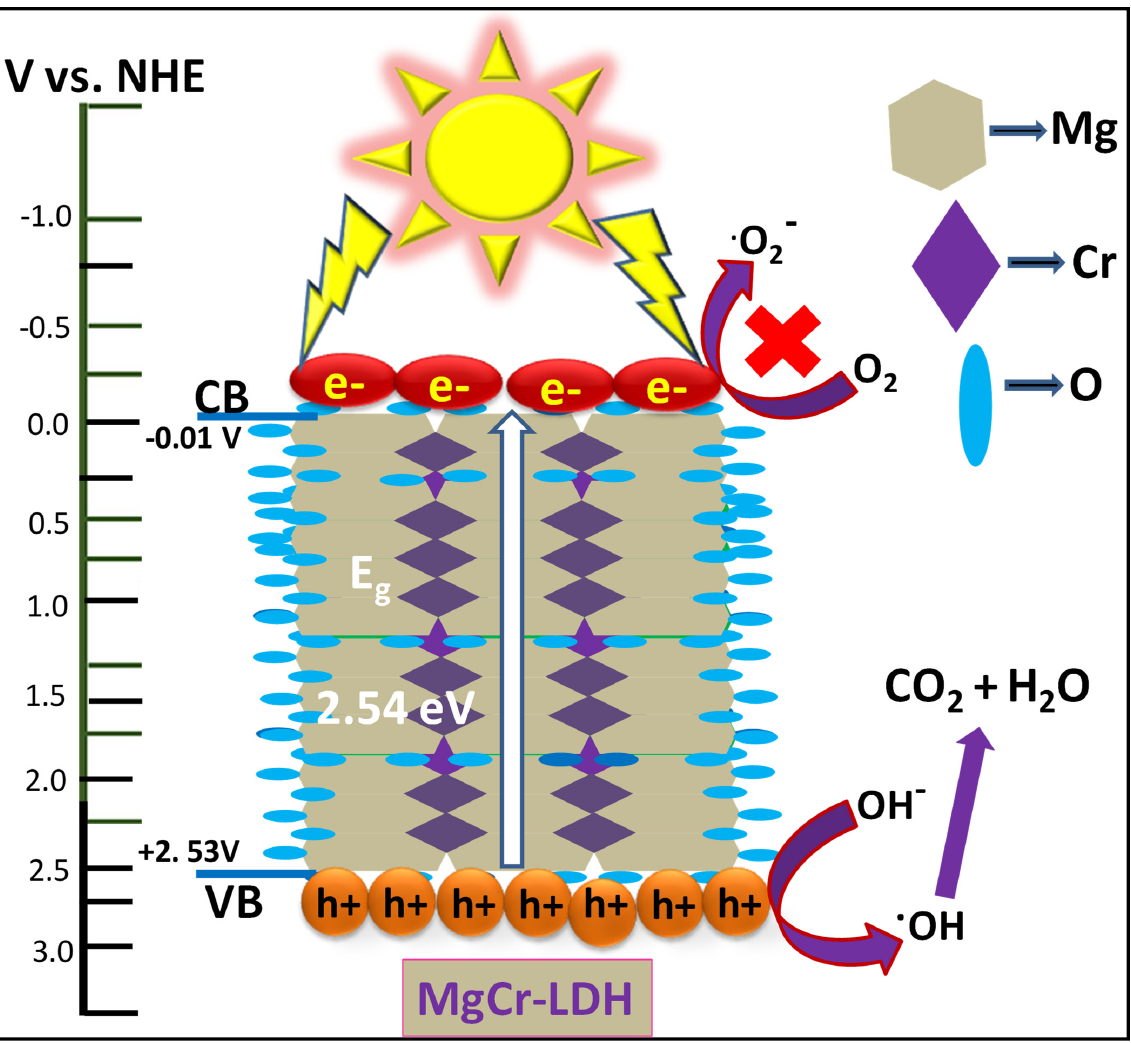
Figure 8. Plausible mechanism of charge separation by MgCr − LDH (3:1, 80 °C) for photocatalytic RhB degradation.